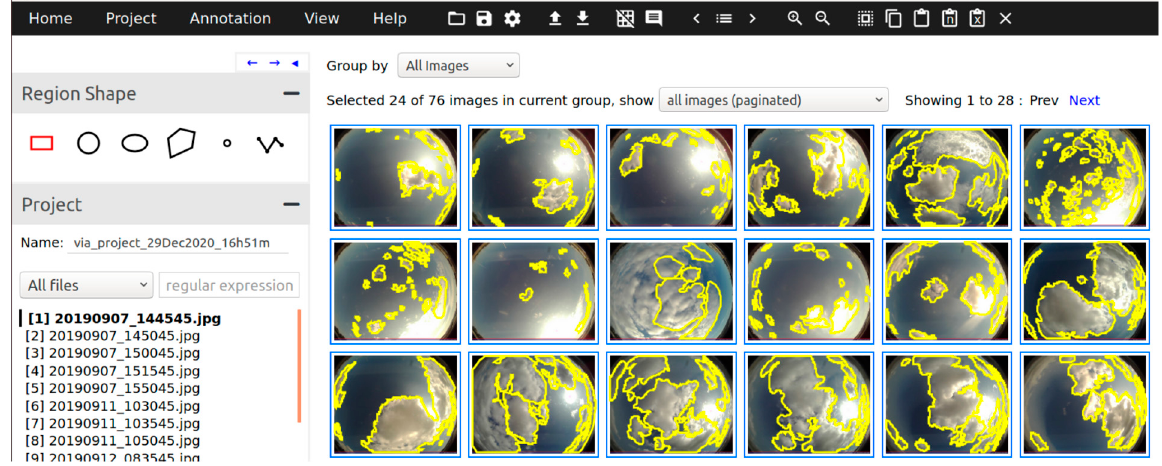
Figure 7. Annotated clouds for training.